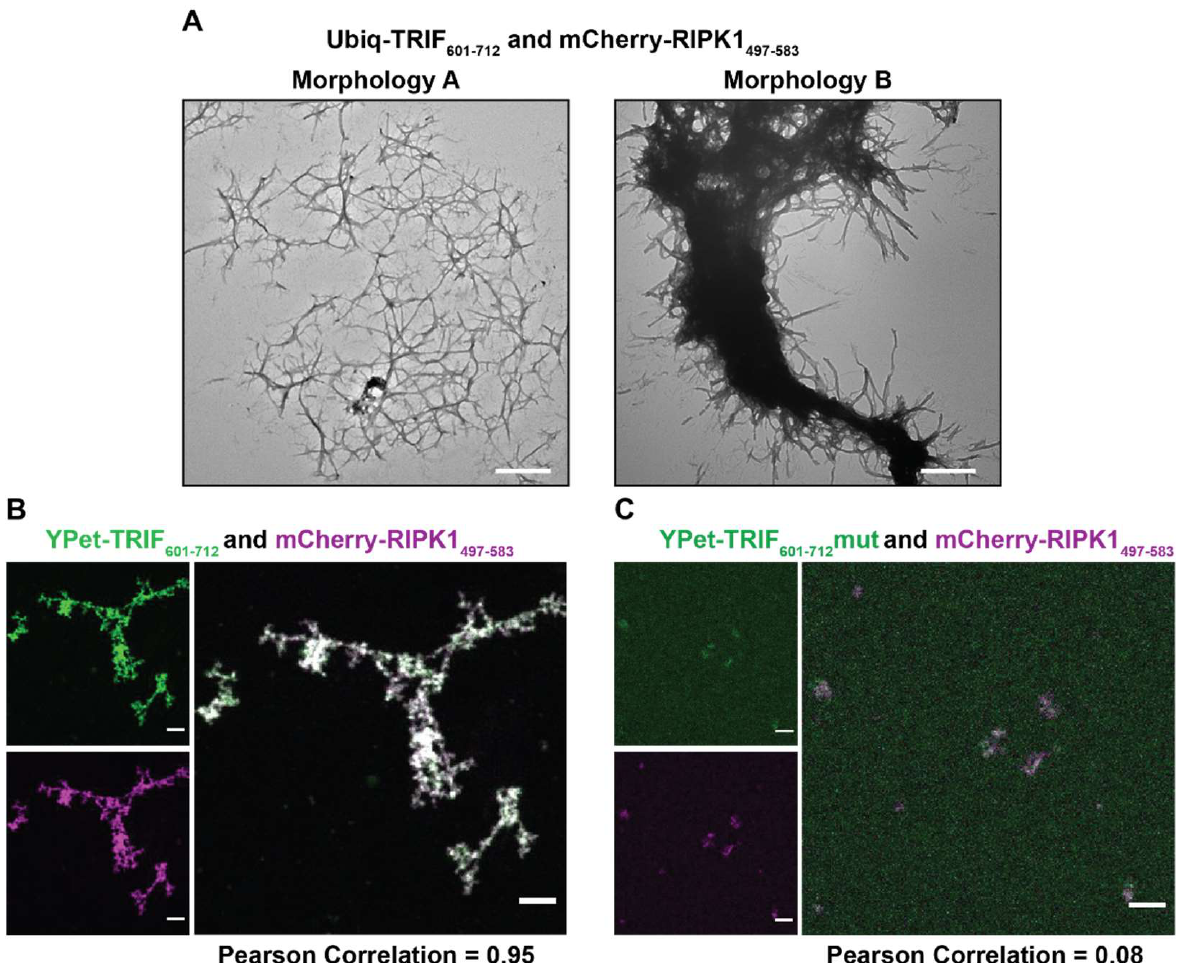
Figure 6. Confocal and transmission electron microscopy of mixtures of TRIF and RIPK1 . ( A ) Transmission electron microscopy of mixtures of 1 µM Ub-TRIF 601–712 and mCherry-RIPK1 497–583 . There were two common morphologies for these mixtures, Morphology A and Morphology B. Scale bars represent 500 nm. ( B , C ) Confocal images of mixtures of 2.5 µ M TRIFwt 601–712 and TRIFmut 601–712 and RIPK1 497–583 RHIM-containing proteins. Images are displayed as recorded in GFP channel, mCherry channel and merged. Scale bar indicates 10 µ m. Image analysis performed in Fiji. Pearson Correlation determined by JaCoP plugin.